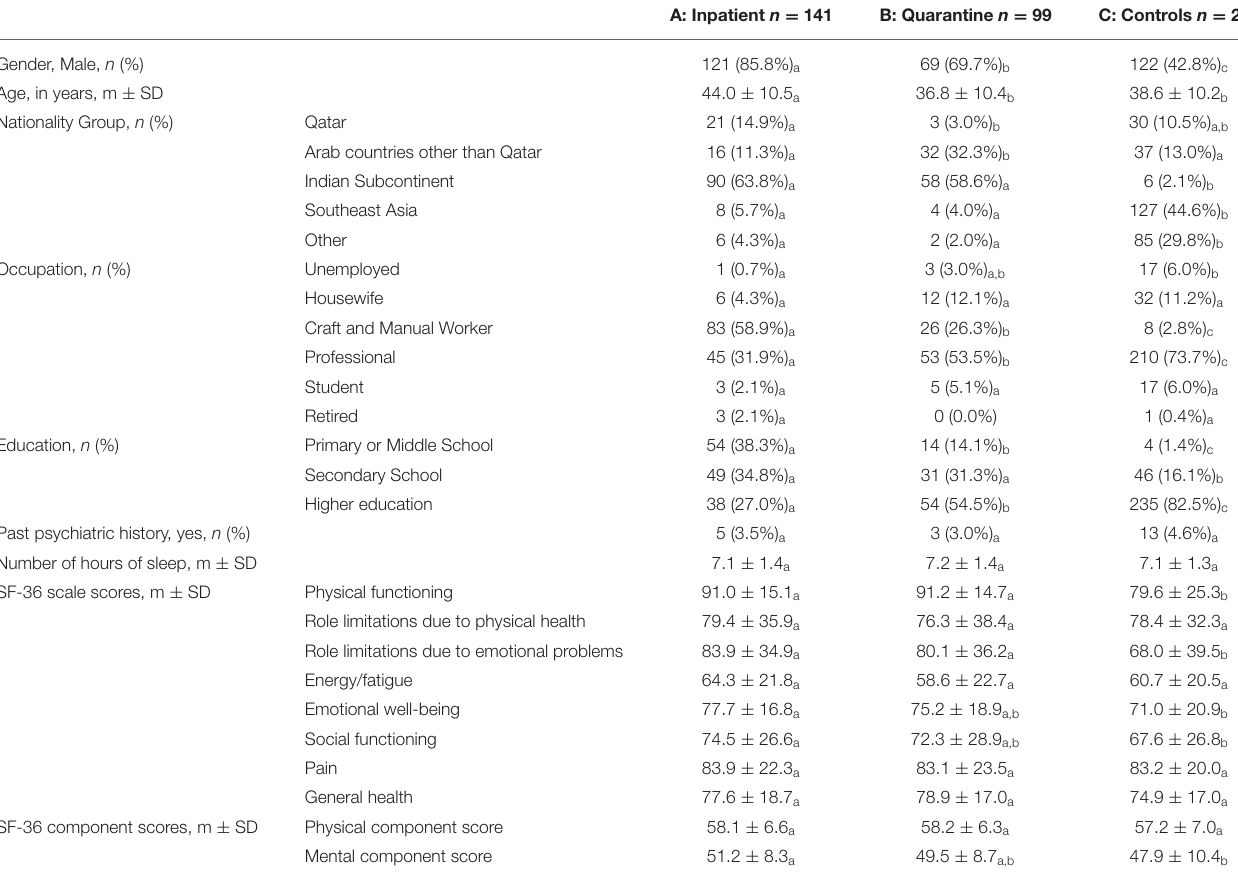
TABLE 1 | Sociodemographic and clinical features of COVID-19 inpatients vs. COVID-19 infected quarantined individuals vs.